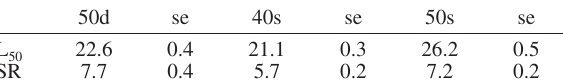
Table 4. – Mean estimates of 50% selection length (L ), selection 50 range (SR) and associated standard errors (se) for the three mesh configurations (50d, 50-mm diamond; 40s, 40-mm square; 50s, 50- mm square).